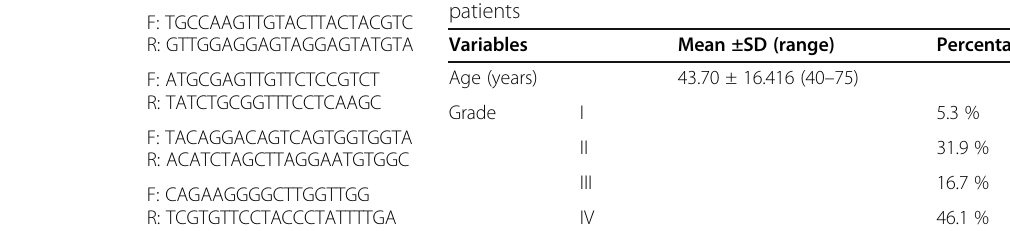
Table 2 Demographic and clinical information of